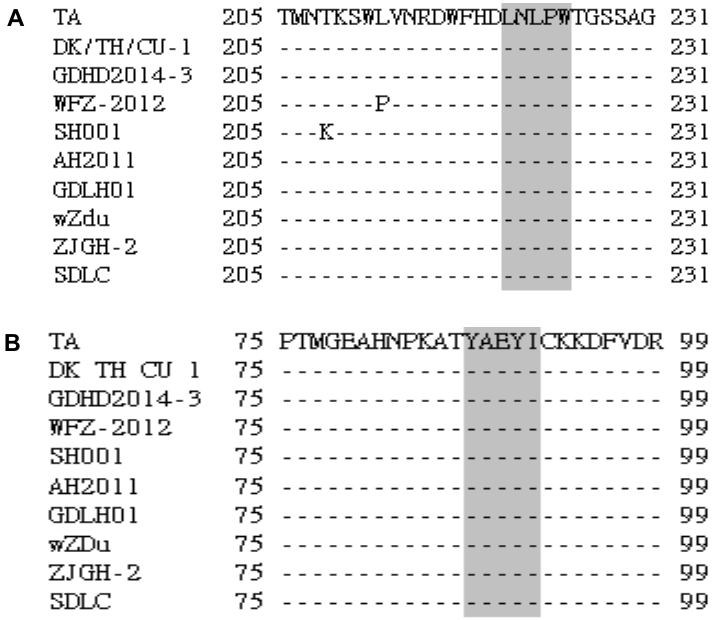
Figure 4. Sequence alignment of the epitope-coding regions LNLPW ( A ) and YAEYI ( B ) in the DTMUV strain E proteins. The amino acid positions for each sequence are numbered on both sides. The DTMUV TA strain sequence is shown at the top; the dashes indicate identical amino acids. The identified epitope region is boxed in grey.